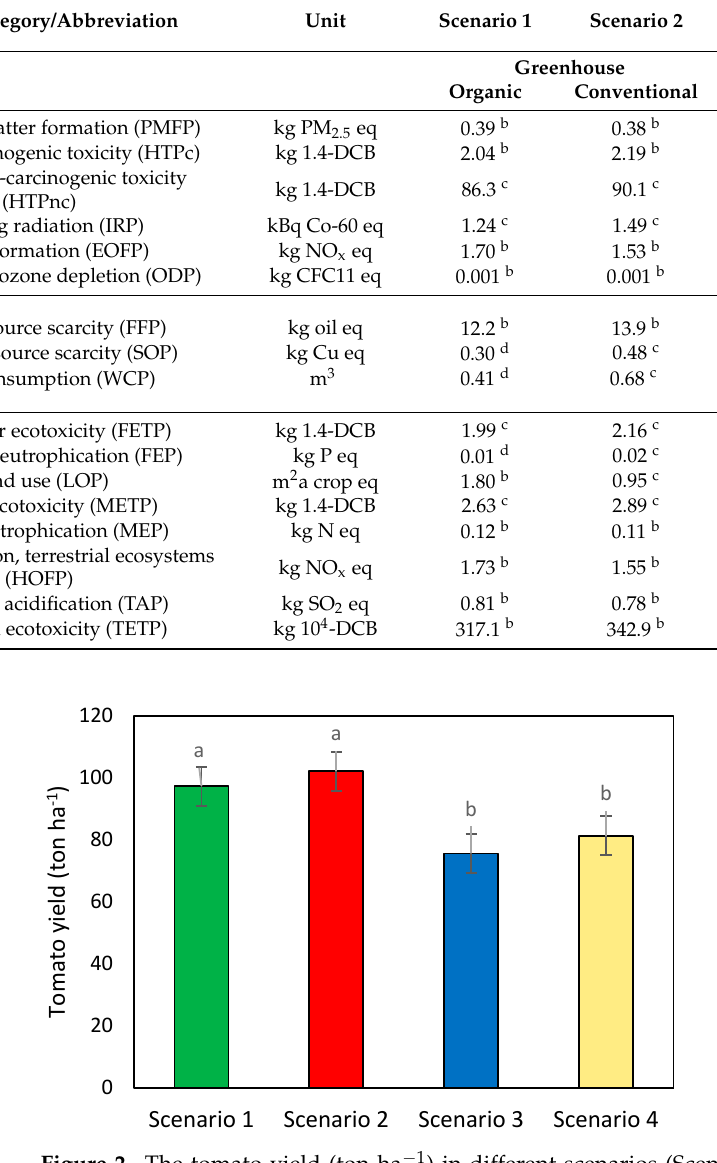
Table 5. Emissions by diesel fuel and natural gas (kg) to air in different scenarios. Different lower cases indicate significant differences.